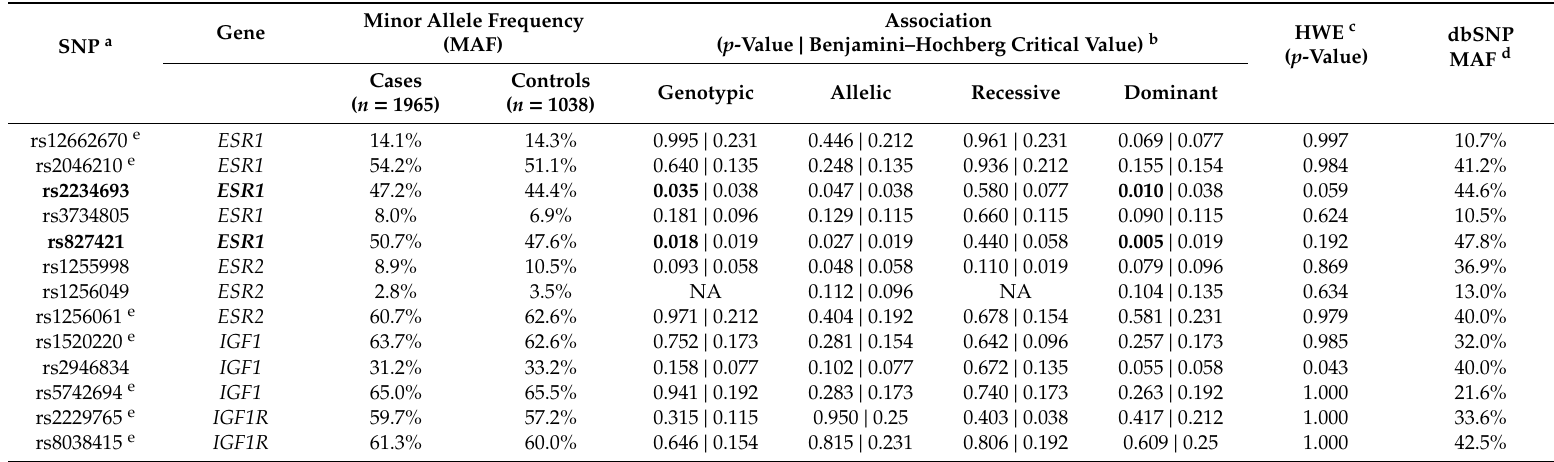
Table 4. Association of the 13 SNP candidates with melanoma in the Gene Environment Association Studies Initiative (GENEVA)